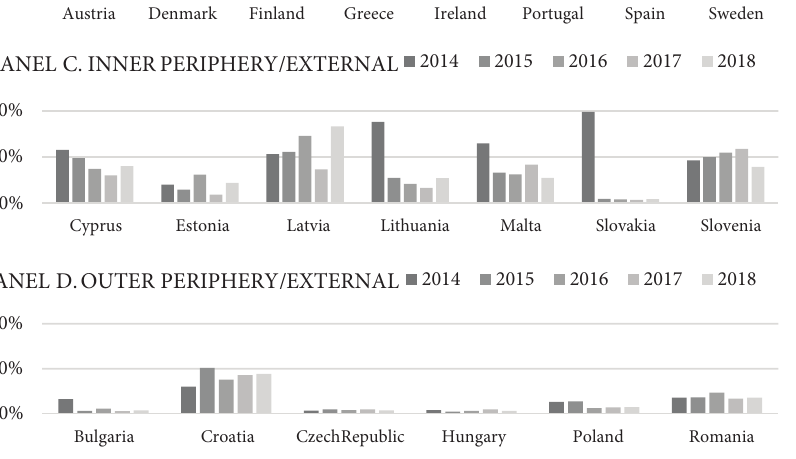
Figure 4. The percentage of surveyed SMEs that declared relevance of external